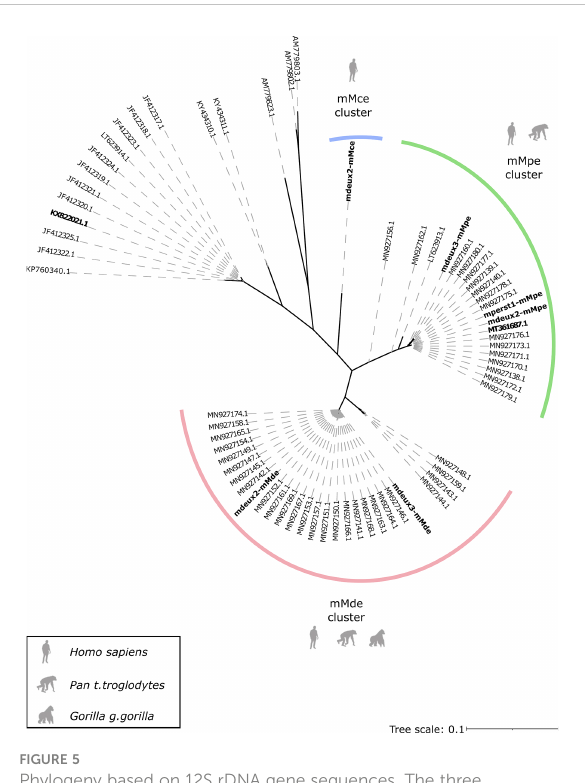
FIGURE 5 Phylogeny based on 12S rDNA gene sequences. The three mitogenome clusters mMpe, mMde and mMce are highlighted in green, red and blue respectively. The generated mitogenomes, as well as the published mitogenomes from M. perstans (GenBank: MT361687) and M. ozzardi (GenBank: KX822021) are highlighted in bold.